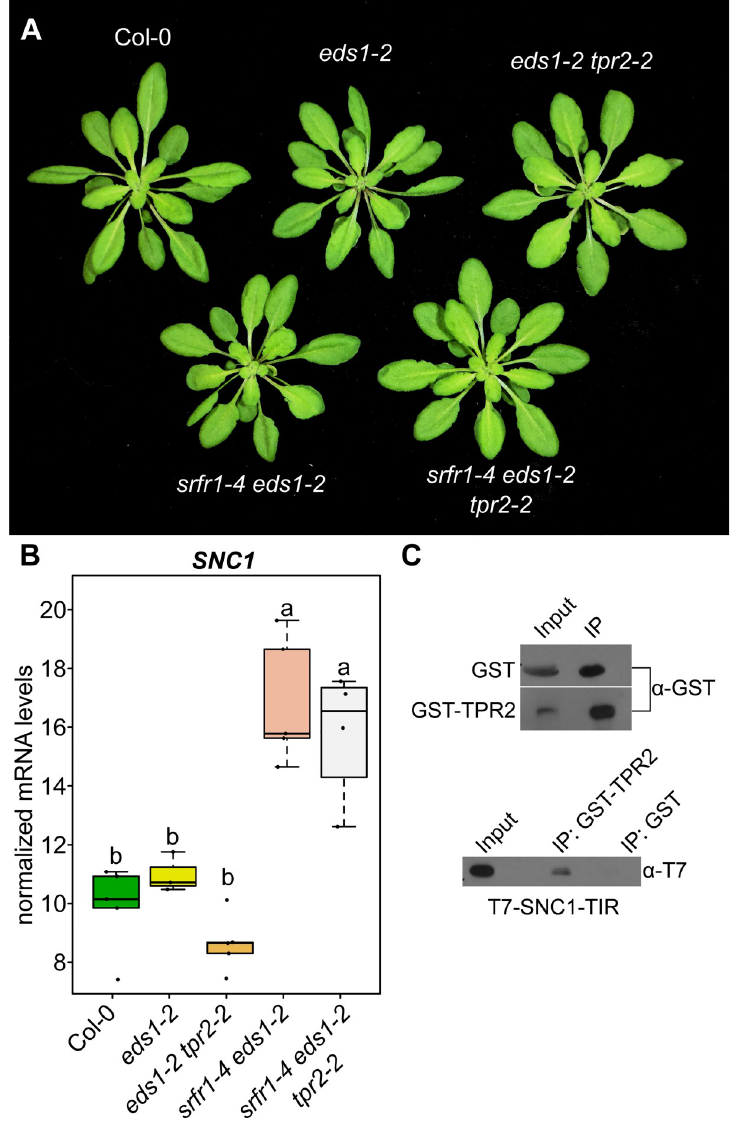
Fig 8. SRFR1 acts upstream of SNC1 transcription. (A) Morphological phenotypes of single, double, and triple mutants of eds1-2 , srfr1-4 , and tpr2-2 . Plants were grown under short day conditions at 21˚C for four weeks. (B) Expression as measured by quantitative RT-PCR of SNC1 . Dots represent individual data points taken over two separate experiments. Genes of interest were normalized against SAND (At2g28390). Whiskers on boxplots are drawn to the farthest data point within 1.5 � IQR of first and third quartiles. Letters denote significant differences as determined by Student’s t-test ( P < 0.01) using the Bonferroni-Holm method to correct for multiple comparisons. (C) In vitro interaction of TPR2 and the TIR domain of SNC1 in E . coli . Proteins were pulled down and subjected to immunoblot analysis with either GST or T7 antibodies. This experiment was repeated once with similar